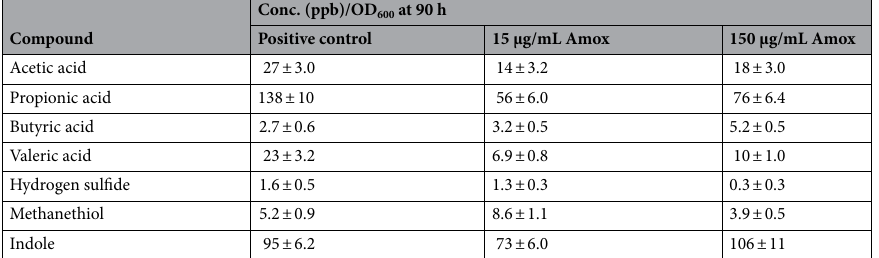
Table 1. Endpoint concentrations of short- and medium-chain fatty acids, nitrogen and sulfur compounds corrected with the corresponding OD 600 value. Concentrations are given as the mean ± standard deviation (SD) of triplicate measurements (N = 3). Positive control is P. gingivalis untreated with amoxicillin.